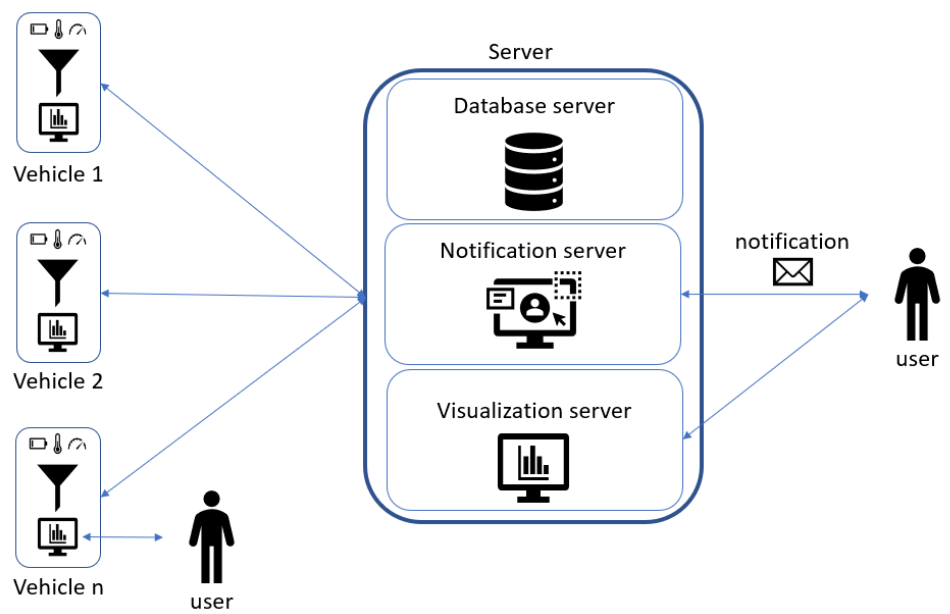
Figure 6. Functional architecture.